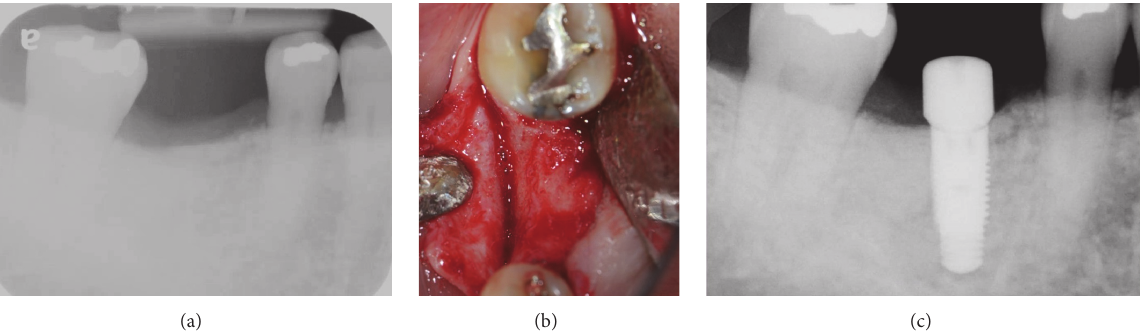
Figure 5: Implant placement five months after the graft procedure. The erratic healing extraction site showed increased radioopacity five months after the bone graft surgery (a). Bone fill was found on the crestal portion of the site (b). Implant was placed at a restoratively driven position